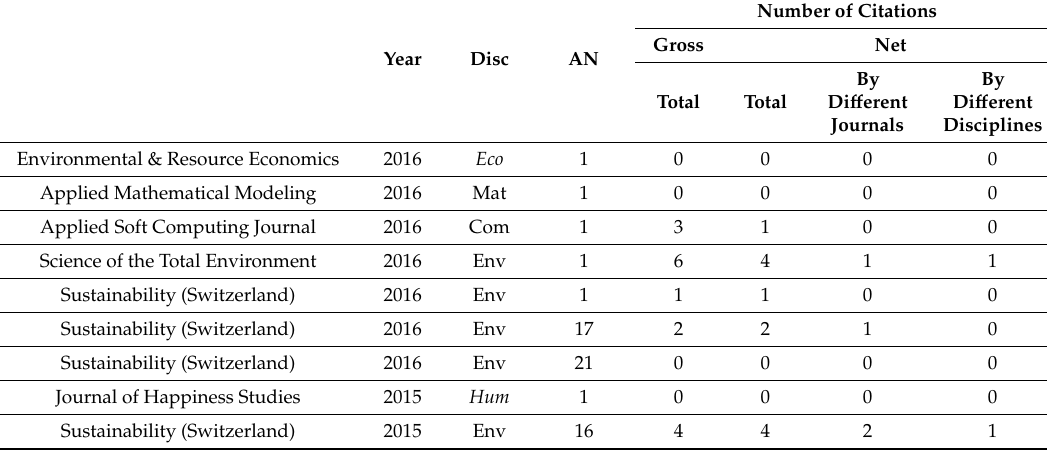
Table A1. Descriptive statistics and Scopus categories for the first analyzed PH, as a representative interdisciplinary and intertopical orthodox PH. Each row represents a single publication; multiple publications in the same journal and same year are represented by separate